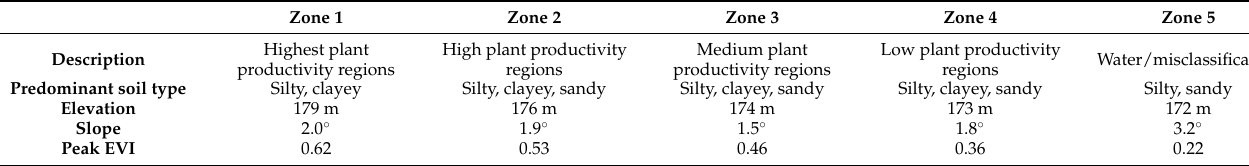
Table 3. Characteristics of each zone from the EVI-based zonation. Slope and EVI values correspond to the mean of the group, and elevation values to the median. The ANOVA test confirmed that these five zones are significantly different for these metrics ( p -values < 1 × 10 − 10